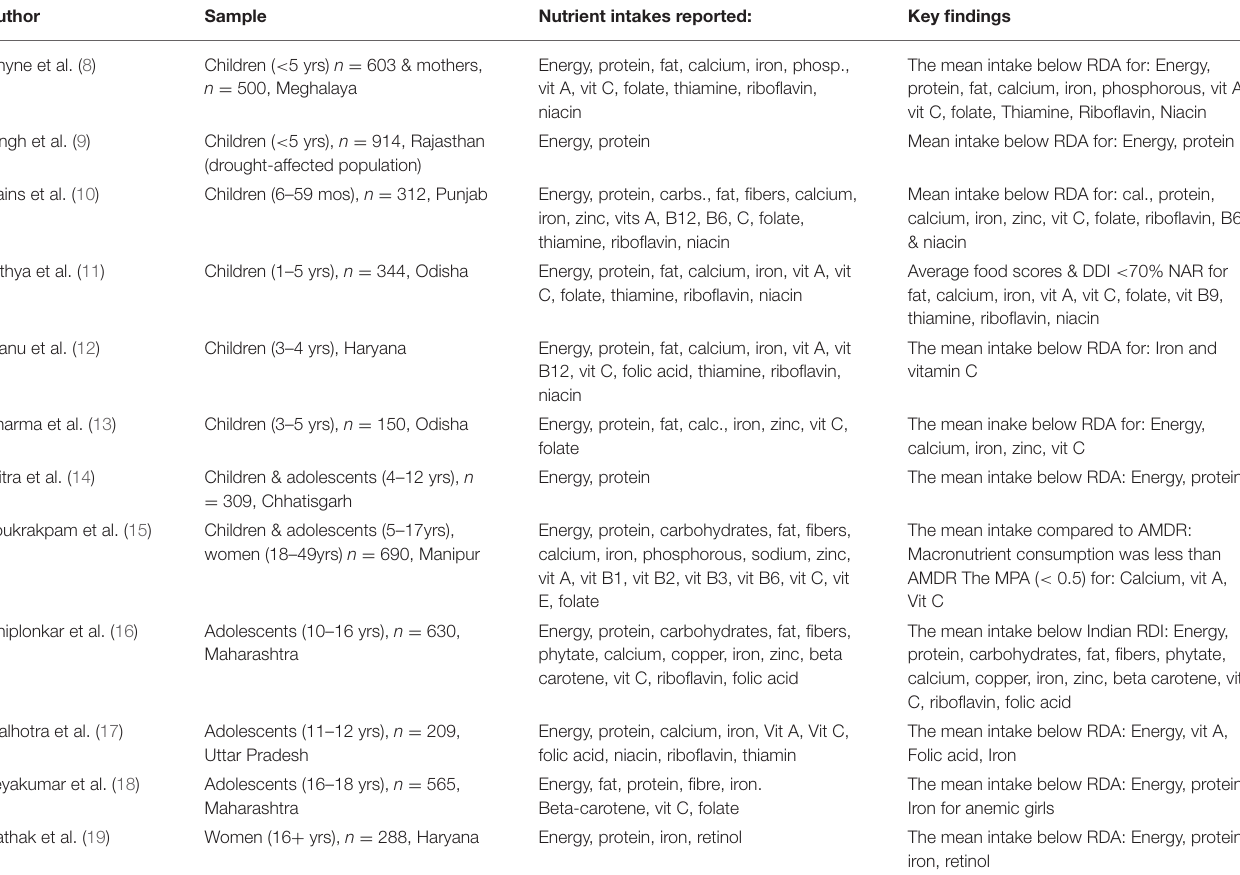
TABLE 3 | Studies assessing nutrient intake of Children and Adolescents (0–18yrs) in